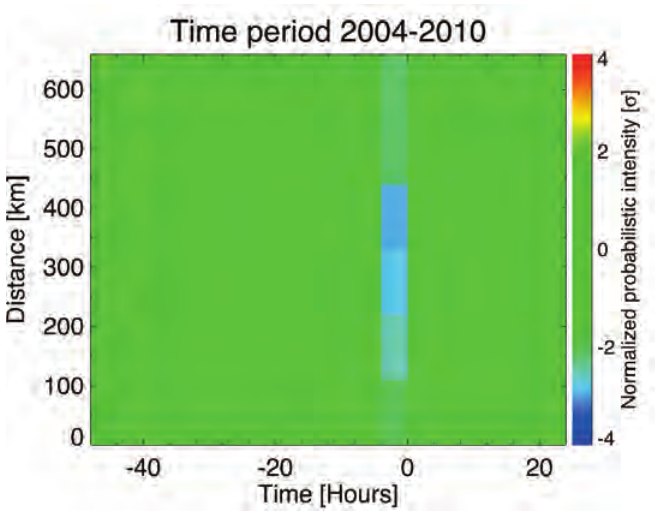
Figure 3. Distance-time dependence of the normalized probabilistic intensity (see text) obtained from the night-time electric field data measured at a frequency of about 1.7 kHz close to earthquakes with magnitude ≥ 5.0 and depth ≤ 40 km.